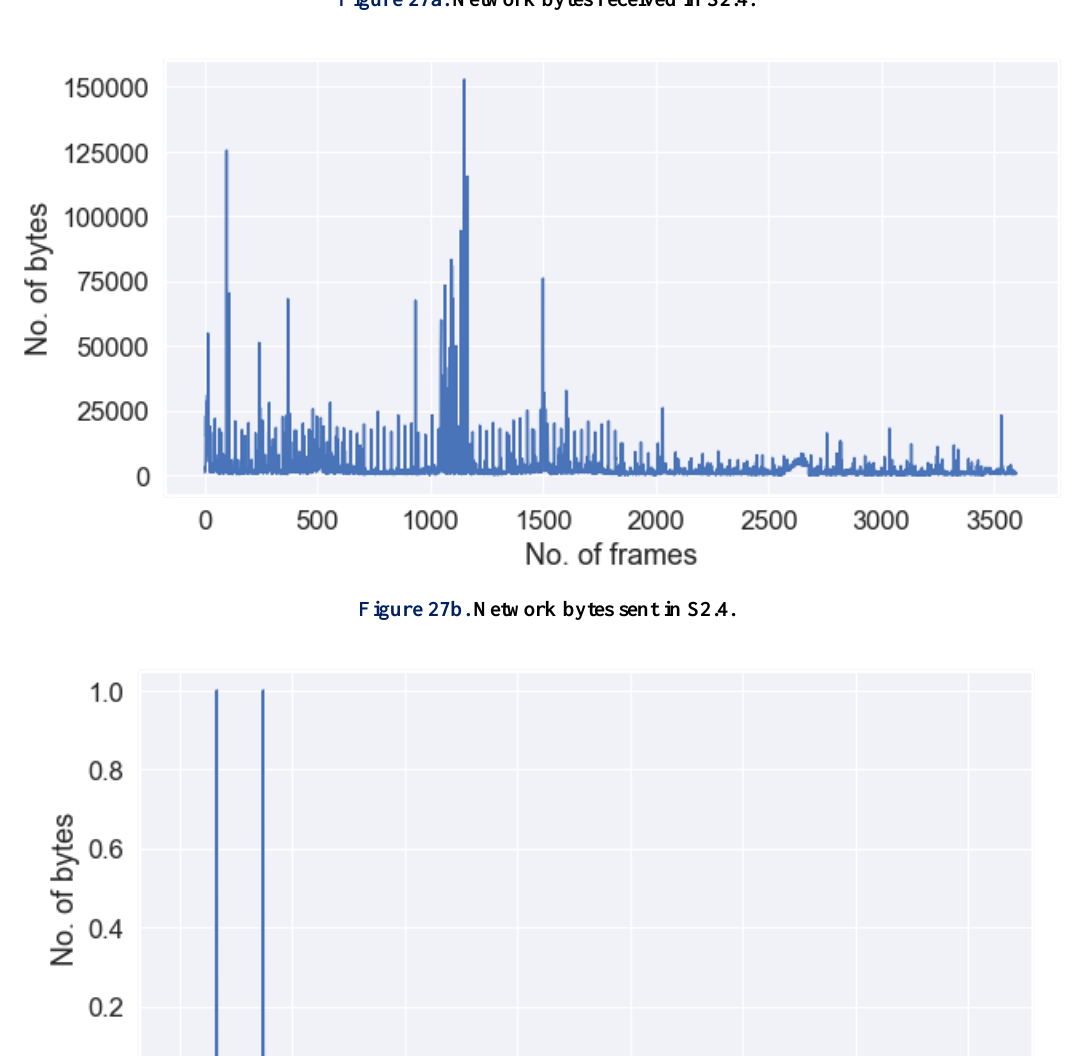
Figure 27a. Network bytes received in S2.4.